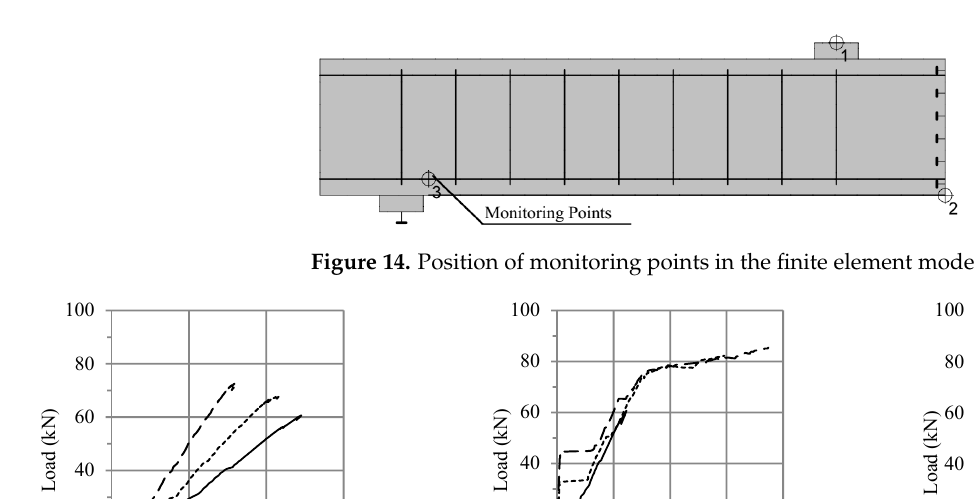
( c ) Figure 12. Comparison between test results and the finite element method (ATENA 2D) ( a ) reinforcement ratio 1%, ( b ) reinforcement ratio 1.5%, and ( c ) reinforcement ratio 2.5%. 5.2. Parametric Study Moreover, the fiber element method was applied to estimate the effect of tensile reinforcement ratio, modulus elasticity of the concrete, and plate thickness on the flexural capacity of RC beam strengthened with CFRP plate. The results of this analysis are shown in Figure 13. It is shown that all three variables increase flexural capacity. ( a ) ( b ) ( c ) Figure 13. Effect of ( a ) ratio of tensile reinforcement, ( b ) the elastic modulus of the concrete, and ( c ) plate thickness on the flexural capacity using RCCSA. To examine the effect of the ratio of tensile reinforcement, the elastic modulus of the